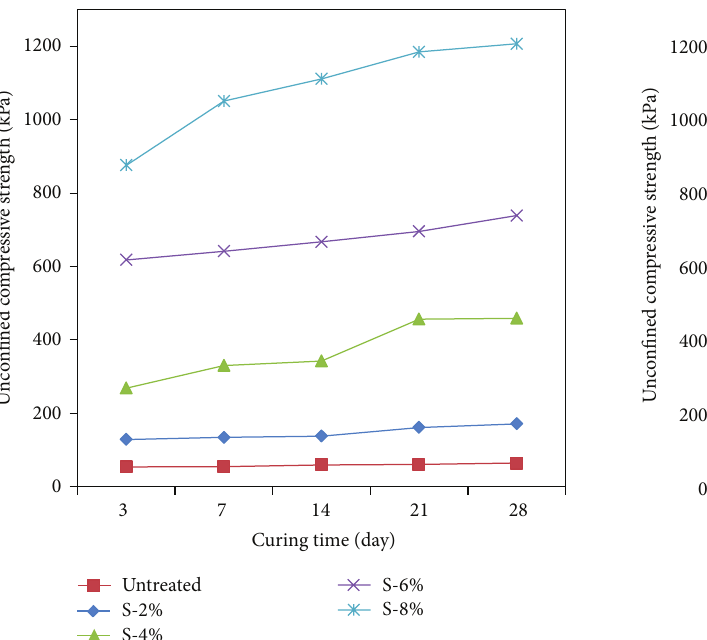
Figure 8: Curing period to compare the strength of cement specimens.